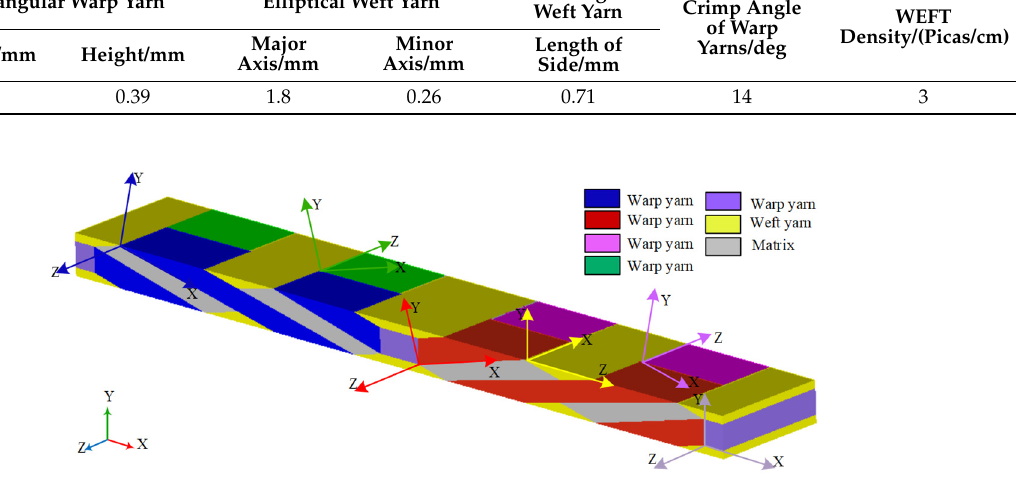
Figure 4. Material coordinate systems of the RVE of braided composite.